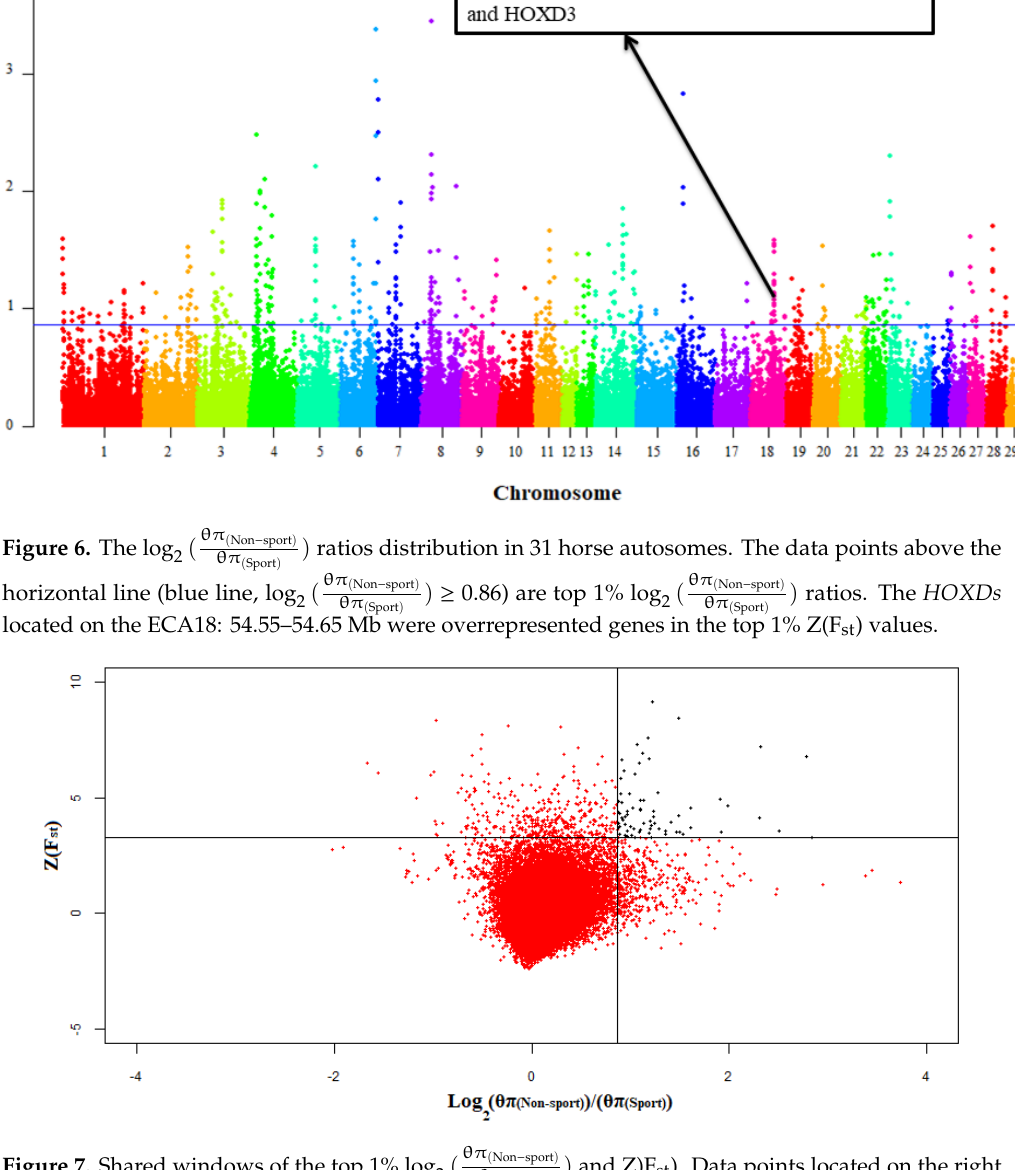
Figure 7. Shared windows of the top 1% log 2 ( side of the vertical line (top 1% log 2 ( above horizontal line (top 1% Z(F st ), where Z(F st ) is 3.26), are identified as shared selective genomic regions.